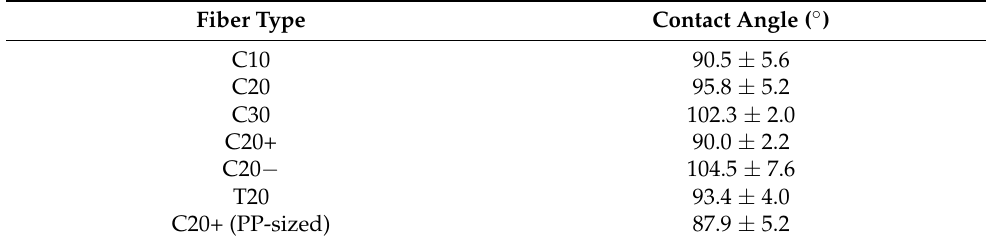
Table 5. Advancing contact angle of the PP fibers in pure water (Wilhelmy method).